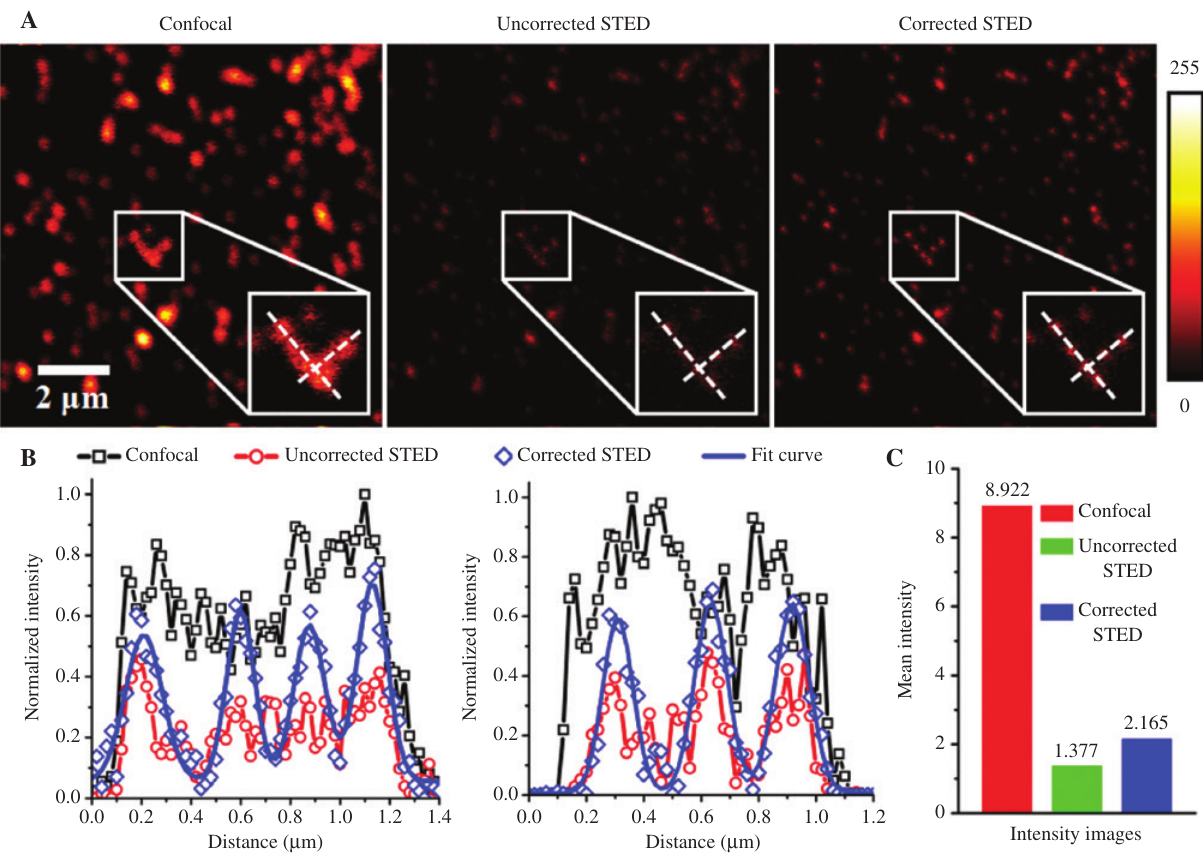
Figure 5: The improvement of image quality of fluorescent microspheres in STED microscopy. (A) Confocal and STED images at the depletion power of 19 mW before and after correcting system-induced aberration. (B) Normalized intensity profiles along two white dotted lines in (A), respectively. (C) The mean intensity of three fluorescence images.